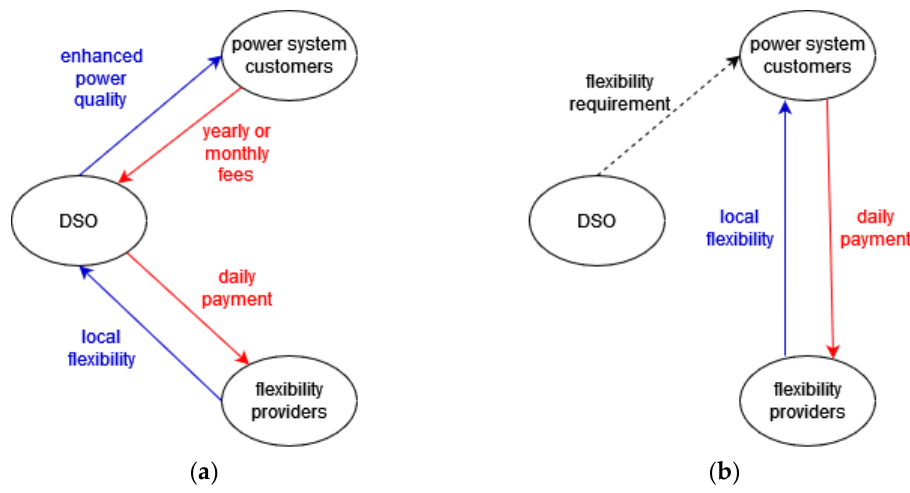
Figure 1. Local flexibility market schemes for ( a ) DSO procurement and ( b ) peer-to-peer trade.